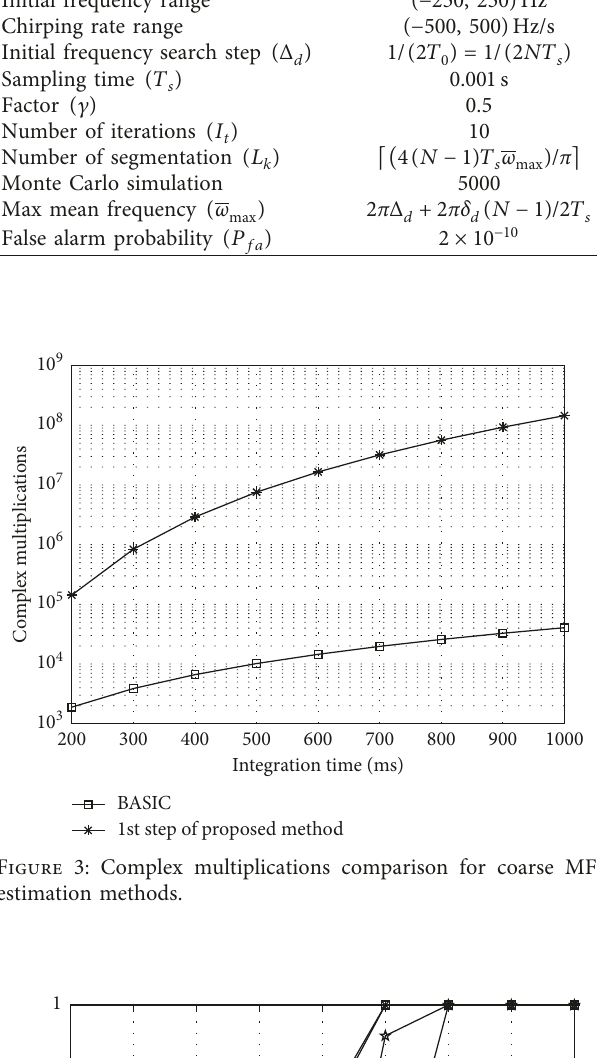
Table 3: SI mulation parameters. Parameters